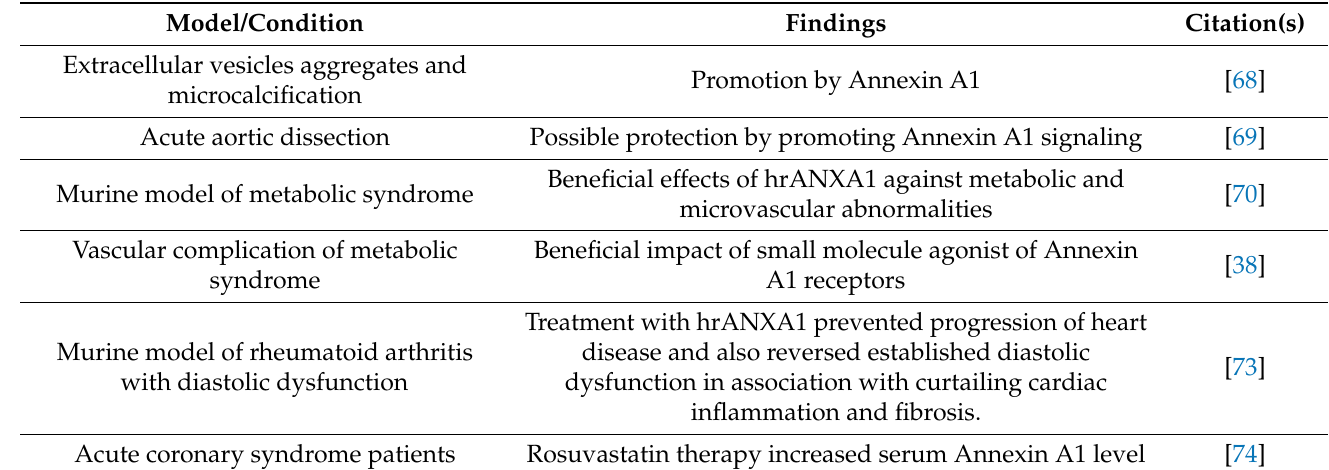
Table 4. Role of and therapeutic potential of Annexin A1 in cardiovascular